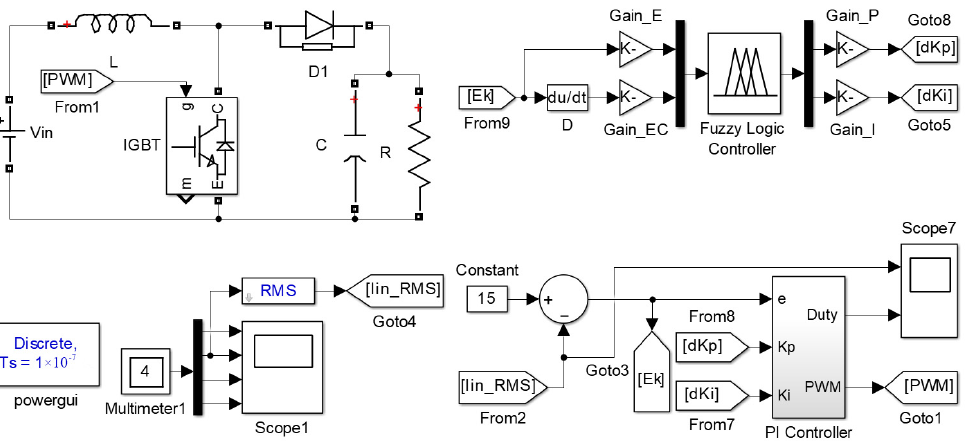
Figure 8. Fuzzy-control-based load simulation control strategy Simulink simulation model. Boost circuit input voltage V IN is 200 V, output voltage V OUT = 400 V, boost